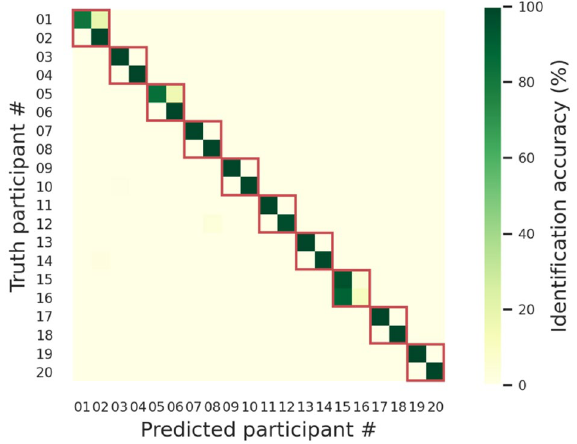
Figure 5. Cross-twin personal identification. Each cell in the confusion matrix indicates the percentage of the model predicting a particular participant (horizontal axis) given the EEG features of a particular participant (vertical axis). Each row was normalized by the total number of instances in that row to factor out the sampling- induced, inequal number of total samples across rows. Note that two consecutive participant IDs correspond to a twin pair (e.g., participants #1 and #2 are one twin pair, and participants #3 and #4 are another pair). The red boxes highlight the confusion submatrix within twin pairs.